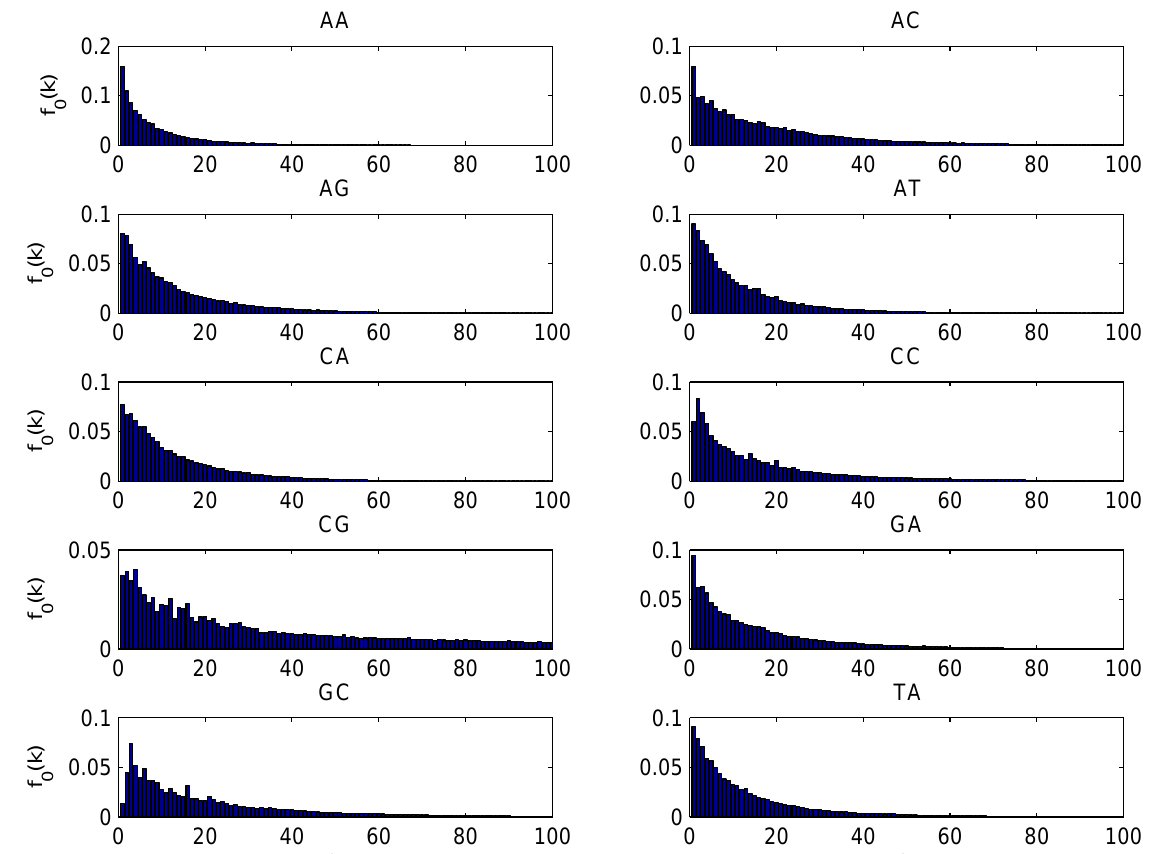
Figure 1: Distribution of the first 100 distances of 10 dinucleotides in the whole human genome (the distributions of the non displayed dinucleotides are very similar to those of the corresponding reversed